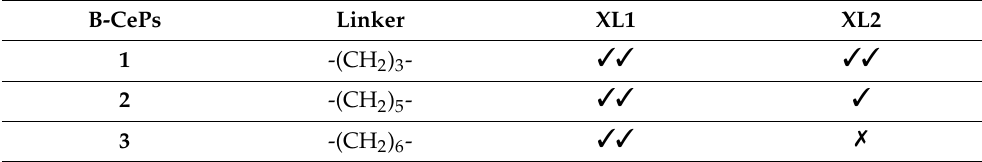
Figure 4 . Representative ESI-MS data obtained from TAR RNA (1 μ M) samples reacted with 10 μ M of either B-CeP 2 ( A ) or B-CeP 3 ( B ) followed by digestion with RNAse A (see Materials and Methods for details). For the sake of clarity, only the relevant crosslinking products are labeled in each spec- trum. Numerous other species corresponding to hydrolytic products were identified (see Figure S2). Cleavage products are identified by the first and last base (e.g., G10:C13) and the number of the respective bi-functional alkylator (i.e., 2 or 3 ). ( C ). Cartoon of the B-CePs-induced bi-functional al- kylation products named XL1 and XL2 within the TAR RNA secondary structure.